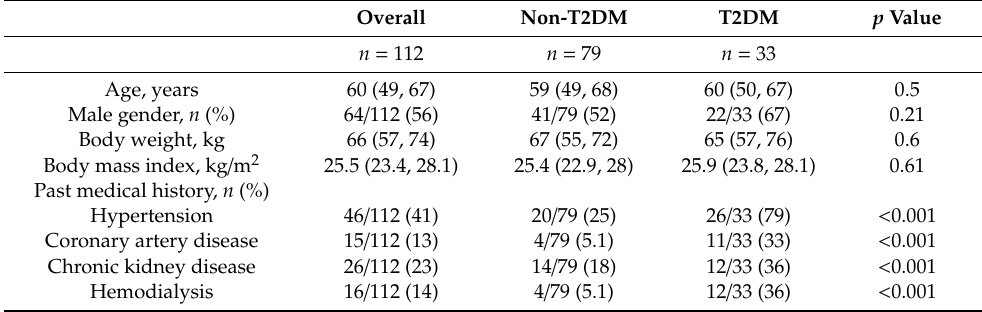
Table 1. Baseline clinical characteristics and lipid profile before and after ezetimibe treatment.